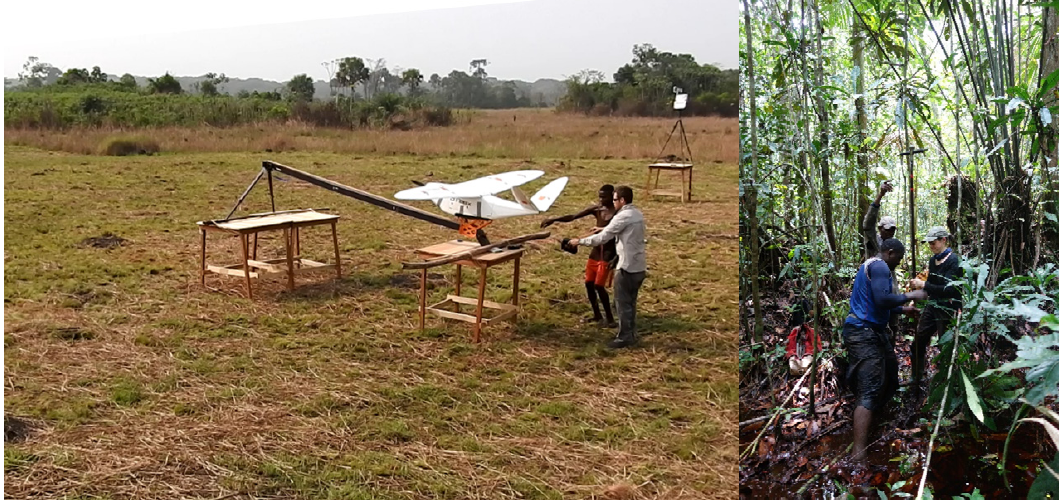
Figure 3. The unmanned aerial vehicle (UAV) prepared for launch at the cleared site near Ekolongouma, and peat depth field measurements being made in the hardwood forest.